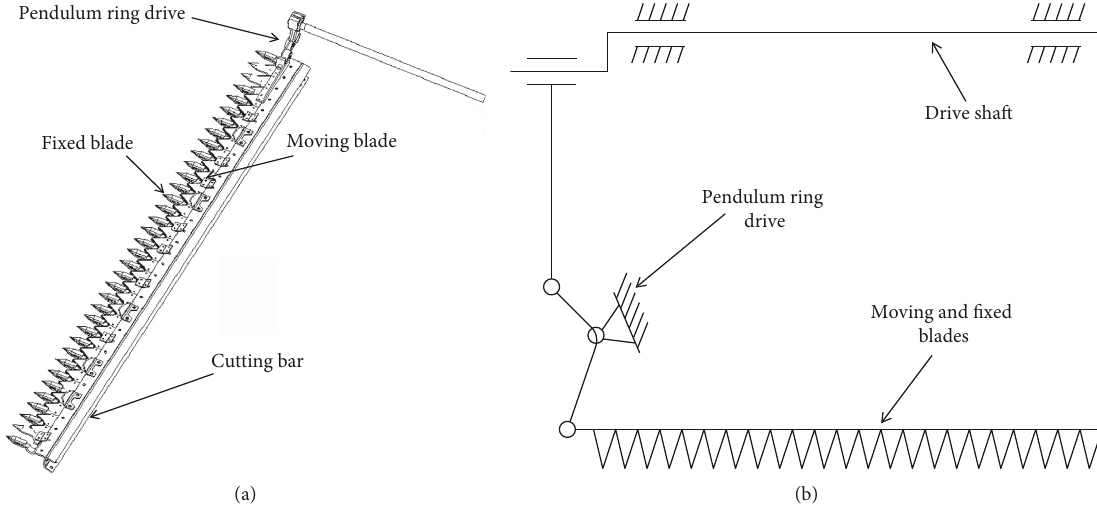
Figure 3: Structure and schematic of the cutting bar. (a) Assembly of the cutting bar. (b) Pendulum drive mechanism.